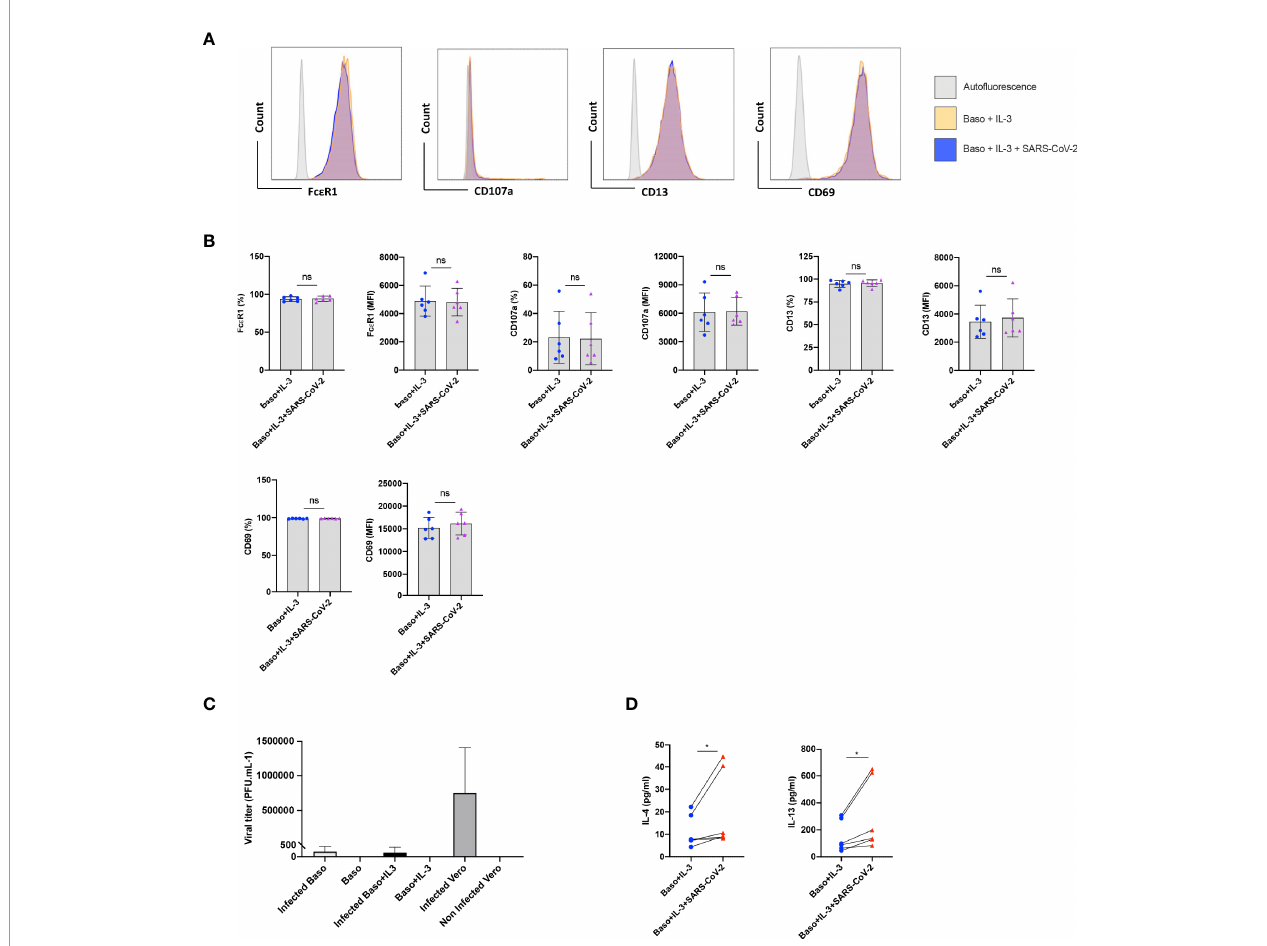
FIGURE 2 | SARS-CoV-2 enhances cytokines in IL-3-primed basophils. Basophils (0.1x10 6 cells/100 µl) from the healthy donors were primed with IL-3 (20 ng/ml) along with infection with SARS-CoV-2 at a MOI of 1. Non-infected basophils were used as a control. Cell phenotype was evaluated by fl ow cytometry after 24